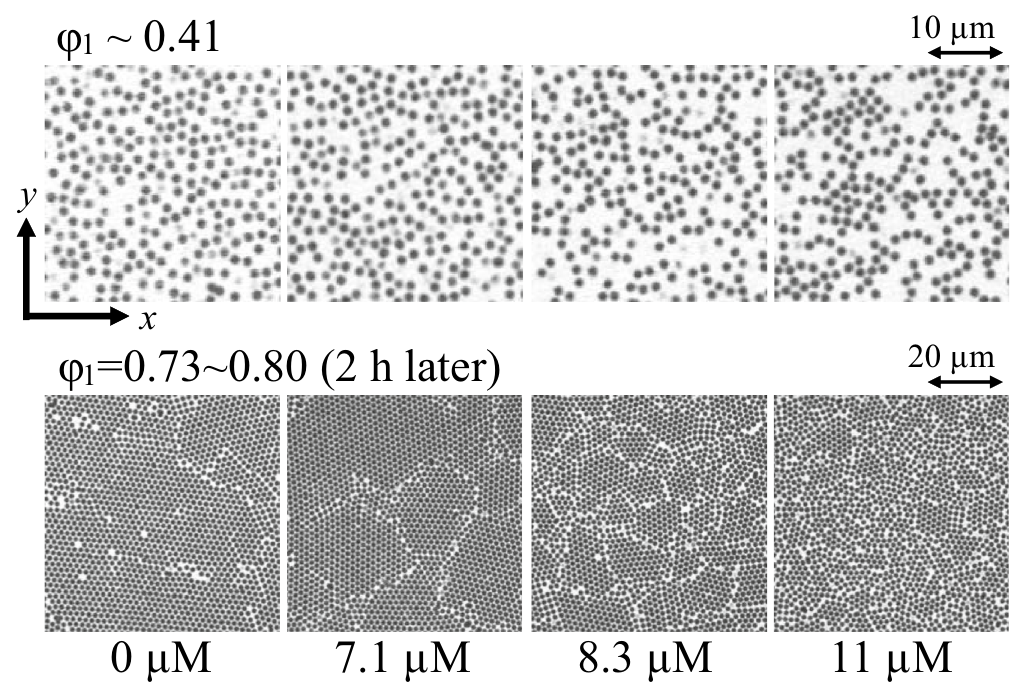
Figure 1. x - y images of the first layer of sedimented particles on the